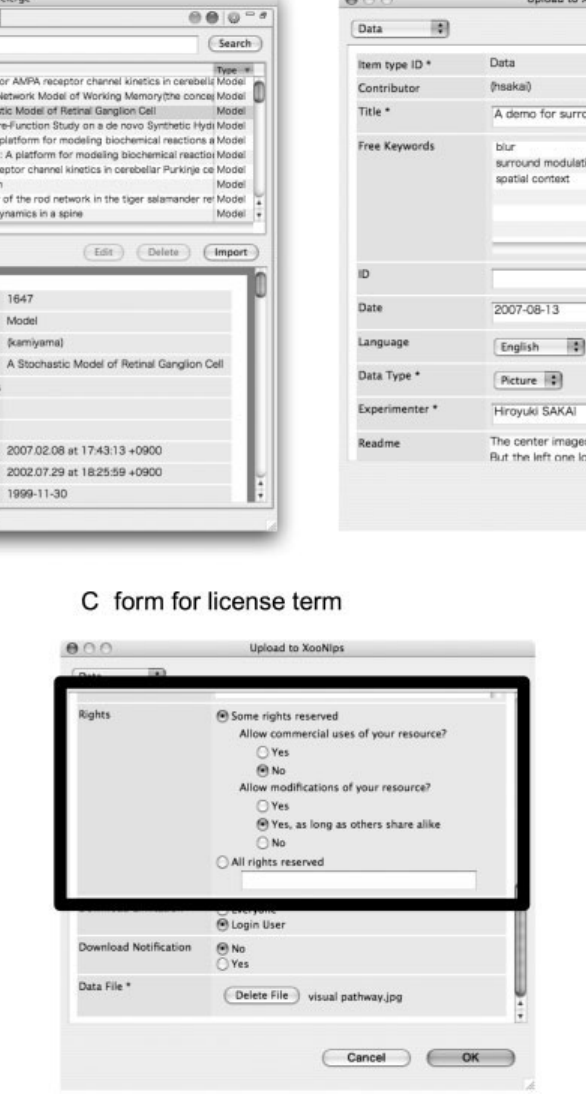
Figure 7. Screenshots of the XoonipsLink plug-in . In the application window ( A ), the hierarchical keywords of XooNIps are shown as a folder tree structure in the left table. The top-right table displays a list of resources that is stored in a folder selected in the left table; the bottom-right table displays metadata of a resource selected in the top-right table. The pop-up dialog ( B ) comes up for editing the metadata required by XooNIps when a “Misc” type resource is dragged and dropped from the Tabulator. This plug-in then takes over a part of the metadata entry using the metadata managed in Concierge. Additionally, to grant an appropriate license to the registered resource, this plug-in supports the CCs licenses. Users can apply one of the CC licenses using only a few mouse clicks ( C ). Panels B and C show different parts of the same dialog window for upload.